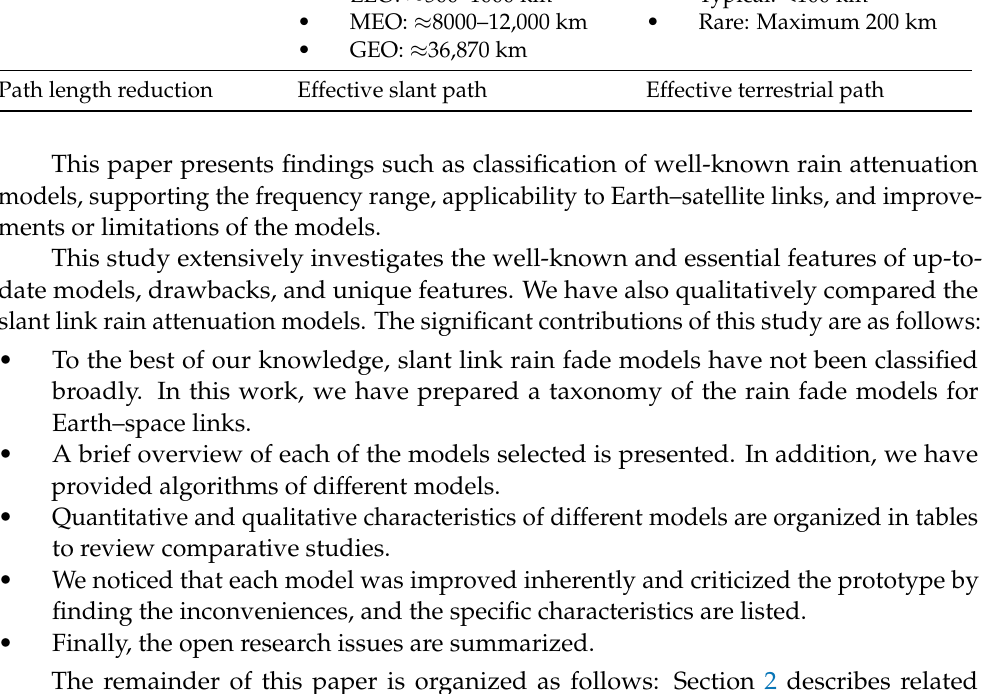
Table 2. Similarity and contrast between Earth–space to terrestrial links. Factors Earth–Space Terrestrial Rain (cid:51) (cid:51) Cloud, sky noise, scintilla- tion, latitude, Earth radius Hop length Varies according to